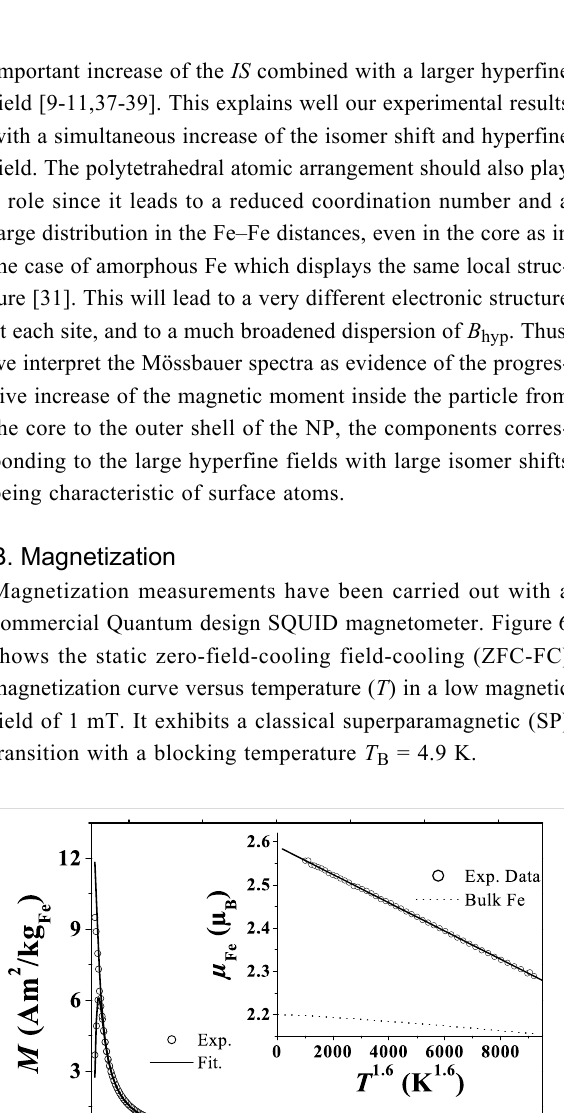
The parameters defining the main contribution are of the same order of magnitude as those measured on slightly larger metallic NPs. For α -Fe NPs with diameters in the range of 3.7 nm, Bødker and coworkers estimated the hyperfine fields to be in the range of up to 45 T with an average IS of 0.5 mm/s [11,37]. Furubayashi found a smaller IS of 0.22–0.27 mm/s for NPs with diameters of approx. 2.0 nm [10]. Mössbauer spectra measured on 1.8 nm metallic NPs stabilised by HN(SiMe 3 ) 2 display two Figure 6: ZFC-FC magnetizations measured under µ o H = 1 mT. Inset shows the extracted temperature dependence of M S .